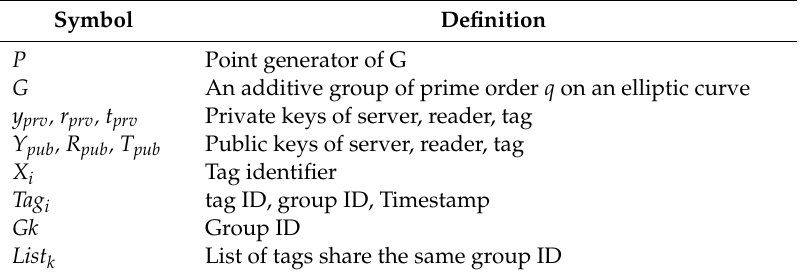
Table 1. Protocol